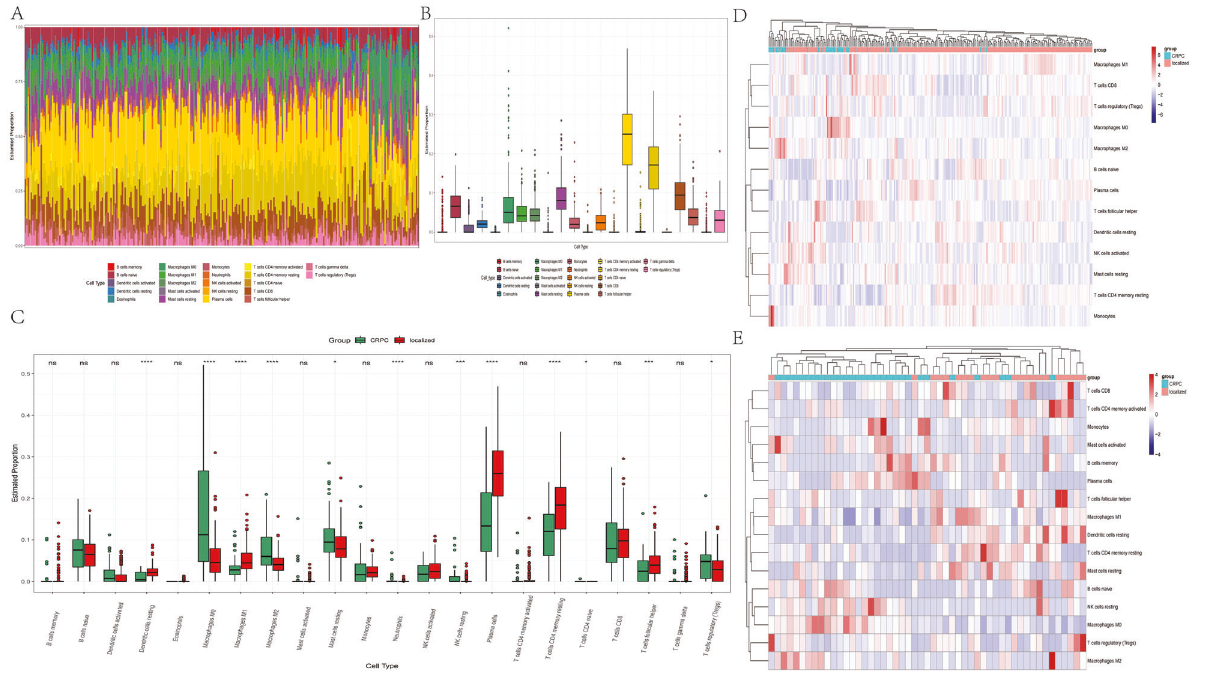
Fig. 5 Immune in fi ltration in the combined sample dateset. A The bar chart shows the composition of the 21 immune-in fi ltrating cells at various sample, with each column representing a sample. B The histogram shows the composition of immune-in fi ltrating cells in all samples. C Comparison of the content of various immune-in fi ltrating cells in CRPC samples and localized PC samples. D The heatmap shows the amount of various immune-in fi ltrating cells in each sample, and each column represents a sample. The grouping of samples is shown in the annotation above. E The concentrations of various immune-in fi ltrating cells in the dataset for GSE32269 with each column representing one sample.